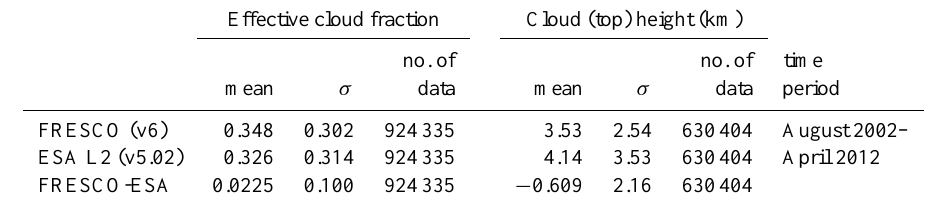
Table 2. Statistics of SCIAMACHY FRESCO (v6) and ESA L2 (v5.02) global cloud products, σ – standard deviation. Effective cloud fraction